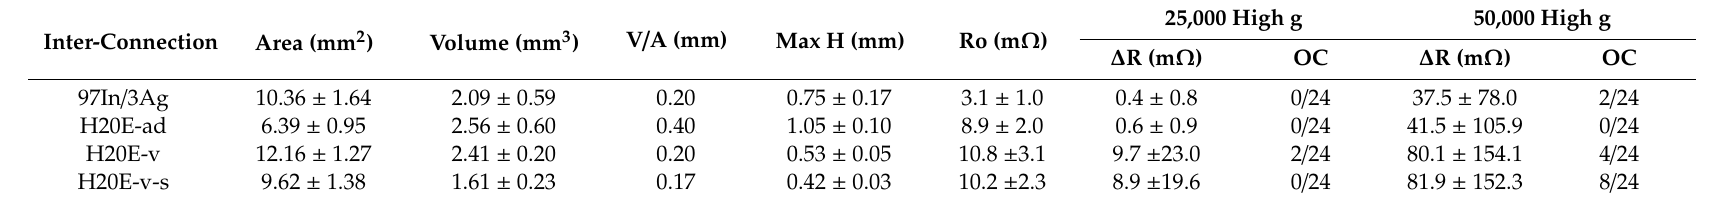
Table 4. High g testing results for silver HPS-FG57B conductive ink.